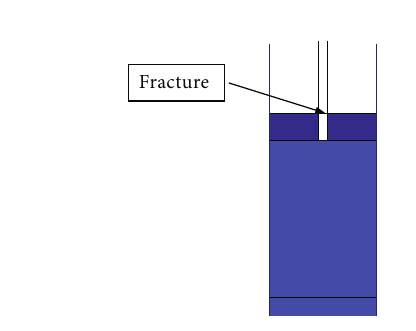
Figure 4: Numerical model of the fracture.